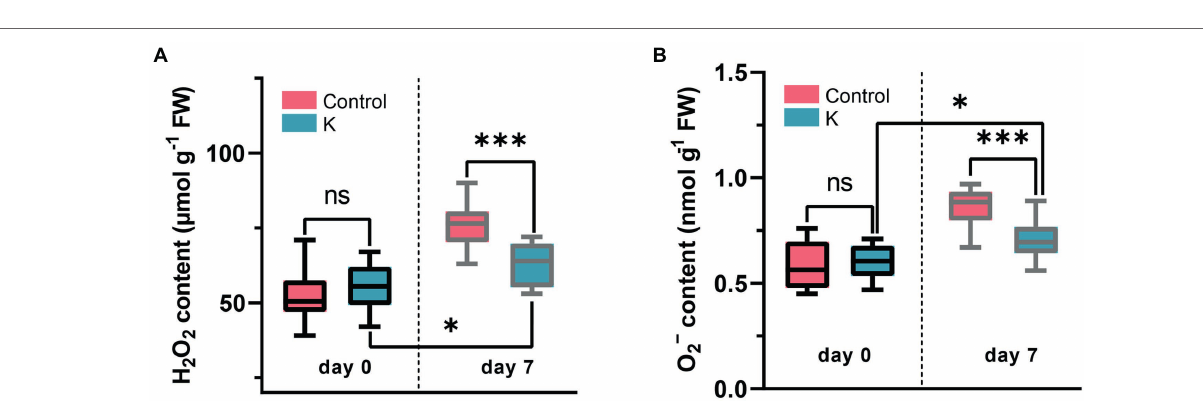
FIGURE 6 | Box plot showing the quantification of H 2 O 2 (A) and •O 2 - (B) in maize leaves grown for 21 days in glass tubes under saline conditions (7 days duration). Asterisks indicate the statistically significant differences compared to controls ( * p < 0.05 and *** p <